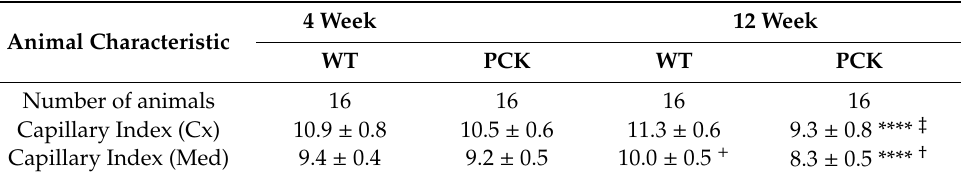
Figure 7. Peritubular capillary loss in PKD. Representative hematoxylin–eosin-stained kidney sections from WT and PCK rats showing capillary loss at 12 weeks. Capillaries were identified by the presence of lumen, red blood cells, and / or an endothelial cell lining (arrowheads), and the ratio of capillary number to non-cystic parenchyma was calculated; (n = 16 / group) Table 2. Capillary index in WT and PCK rats.